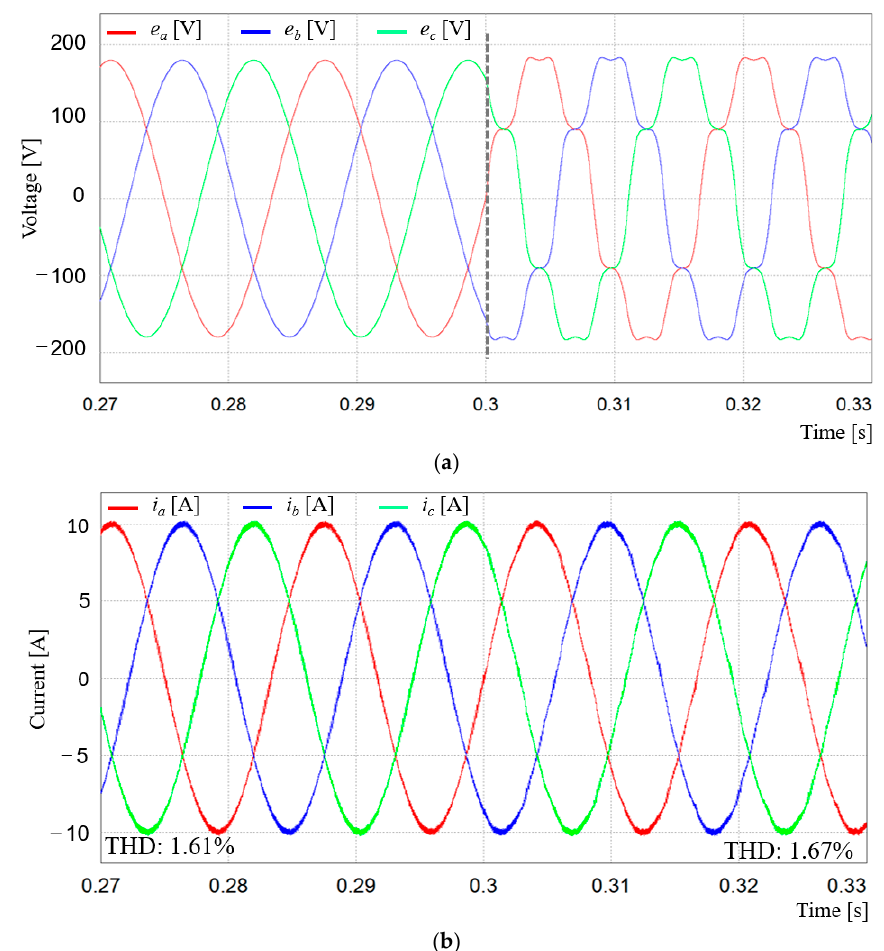
Figure 10. Transient response of the proposed FCS-MPC scheme under sudden change in grid condition. ( a ) Three-phase grid voltages; ( b ) three-phase inverter currents.